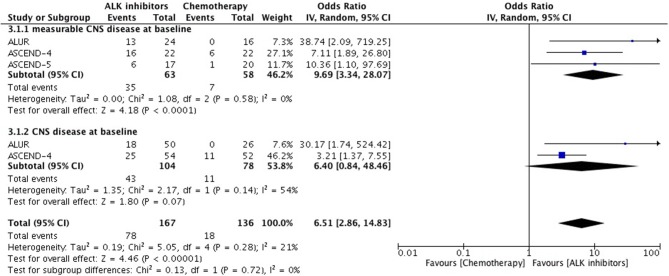
Forest plot of meta-analysis of the Intra-cranial response rate (ICRR) showing comparison of ALK inhibitors to chemotherapy in ALK positive NSCLC.